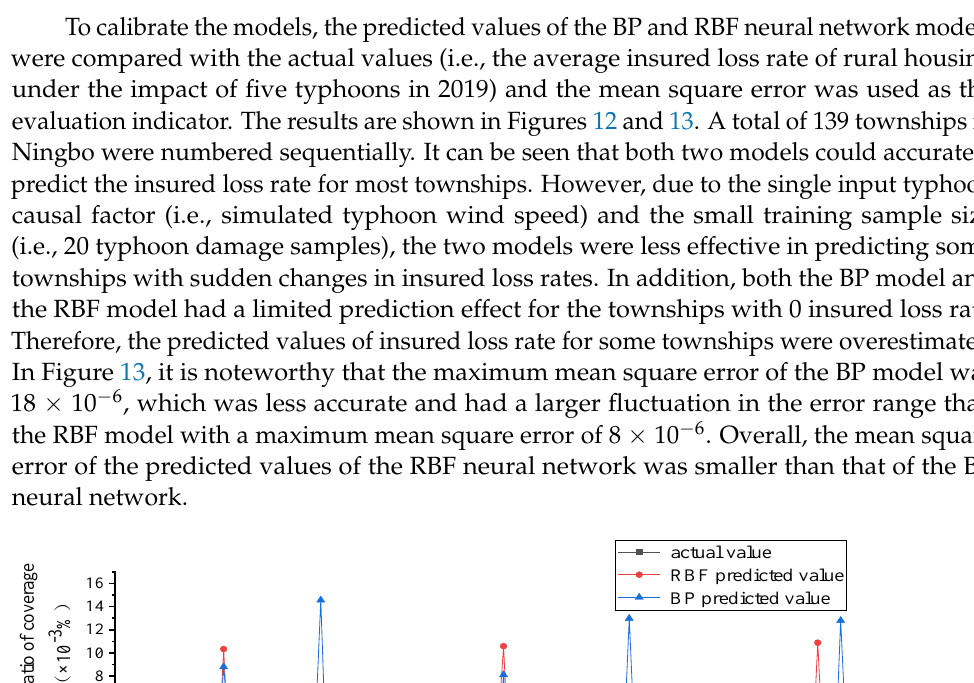
Figure 12. Comparison of average insured loss rate by township due to five typhoons in 2019.